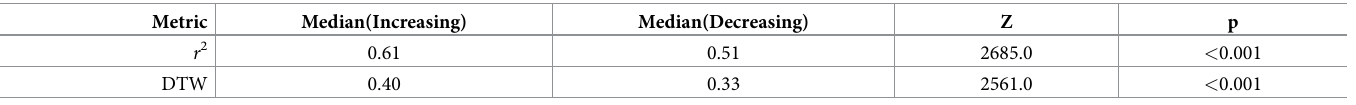
Table 1. The results of the Wicoxon Signed Rank Test comparing increasing and decreasing periods of restrictions for each adherence metric across the 12 month period from March 2020 to the end of February 2021. Metric